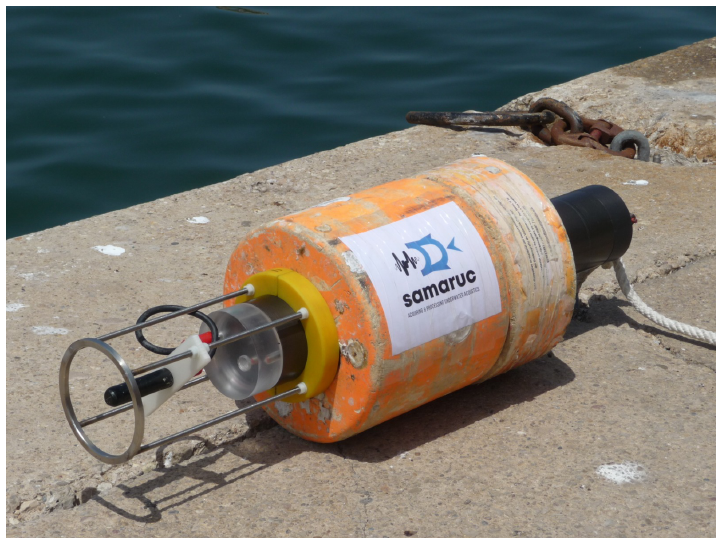
Figure 4. SAMARUC